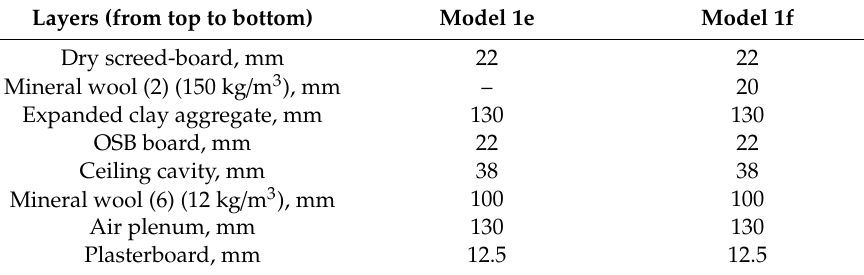
Figure 4. Basic construction of the wooden floor (model 1a) in a test facility.